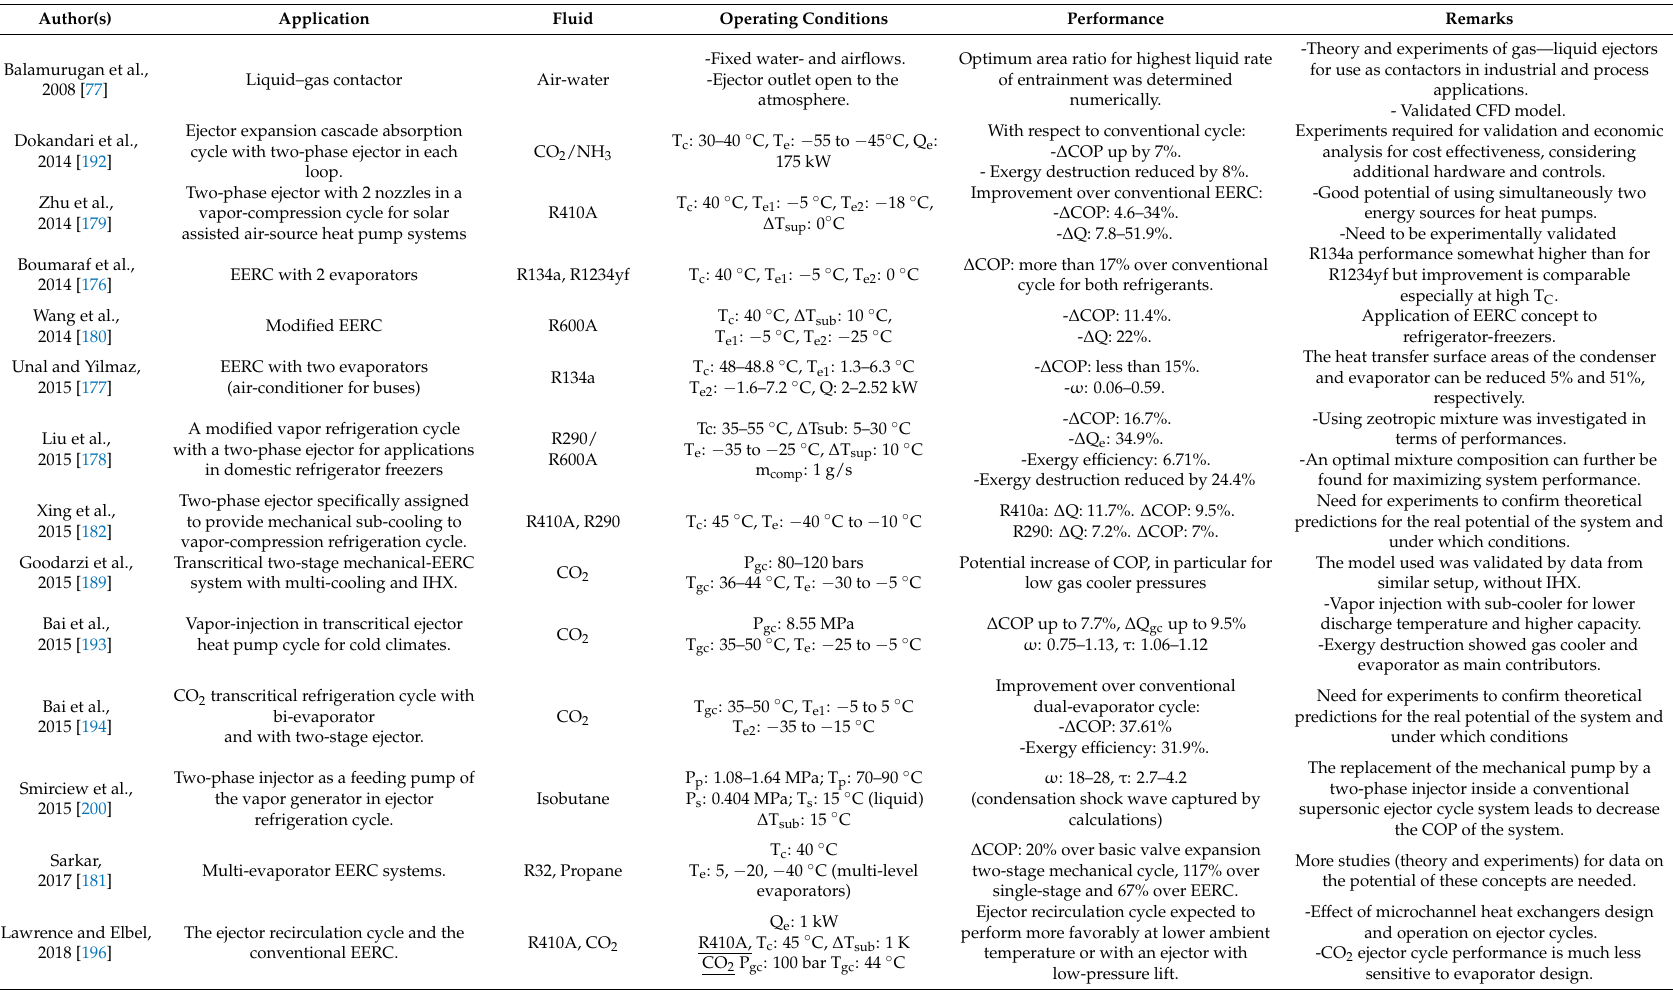
Table 8. Miscellaneous two-phase ejector applications (theoretical